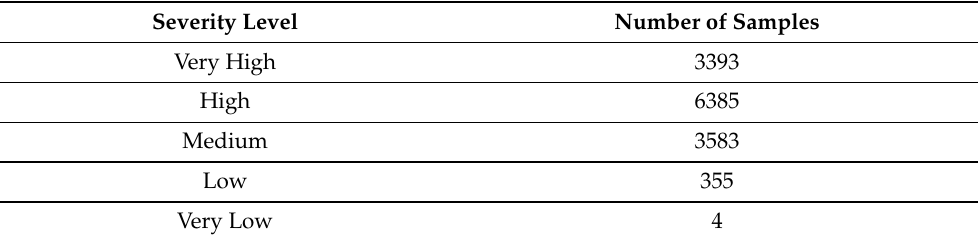
Figure 7. Histogram of the number of samples per severity level in the test data. Table 8. Number of samples per severity level in the vulnerability assessment test